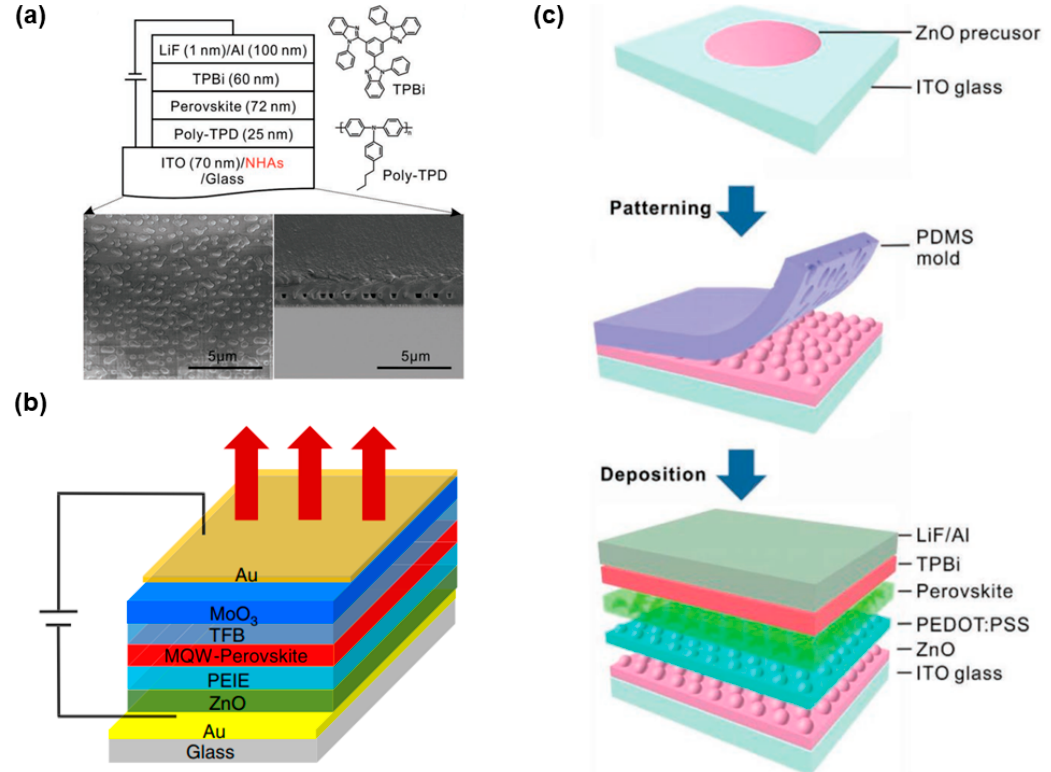
Figure 10. ( a ) Device structures of PeLEDs with and without nanohole arrays (NHAs), the molecular structure of organic transporting layers, and SEM images of the structure. Reproduced from reference [237], John Wiley and Sons, 2019. ( b ) Structure of the PeLEDs. A thick gold film was used as the total-reflection bottom electrode, and a thin gold film was used as the semitransparent top electrode, forming a Fabry-Perot microcavity. Reproduced from reference [240], Springer Nature, 2020. ( c ) Schematic illustration of the fabrication process of a PeLED with imprinted nanostructures. Reproduced from reference [91], John Wiley and Sons, 2019.